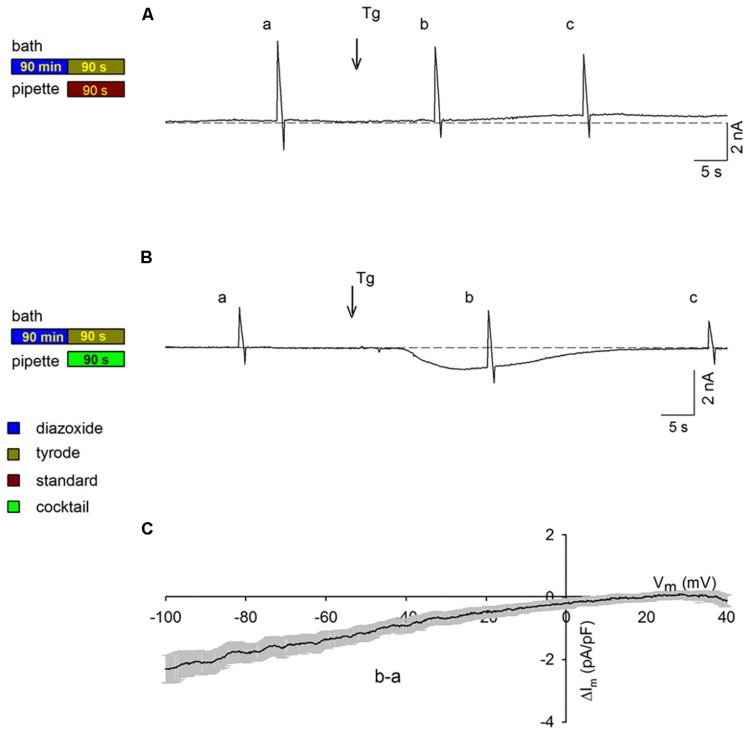
Activation of SOCs in PPC cardiomyocytes with energized mitochondria upon voltage ramp application. The experimental protocol employed for each experiment is summarized to the left of the data associated with that experiment. Ramps were applied at points a–c in the traces. Arrows show the addition of Tg; HP = –80 mV. (A,B) Representative continuous recordings of membrane currents in PPC cardiomyocytes (pretreated with Dzx) exposed to a standard pipette solution (A) or to a mitochondrion energizing cocktail pipette solution (B). (C) Mean current values (±SEMs, n = 6) of SOC currents b–a as a function of membrane potential from experiments performed as in panel (B).